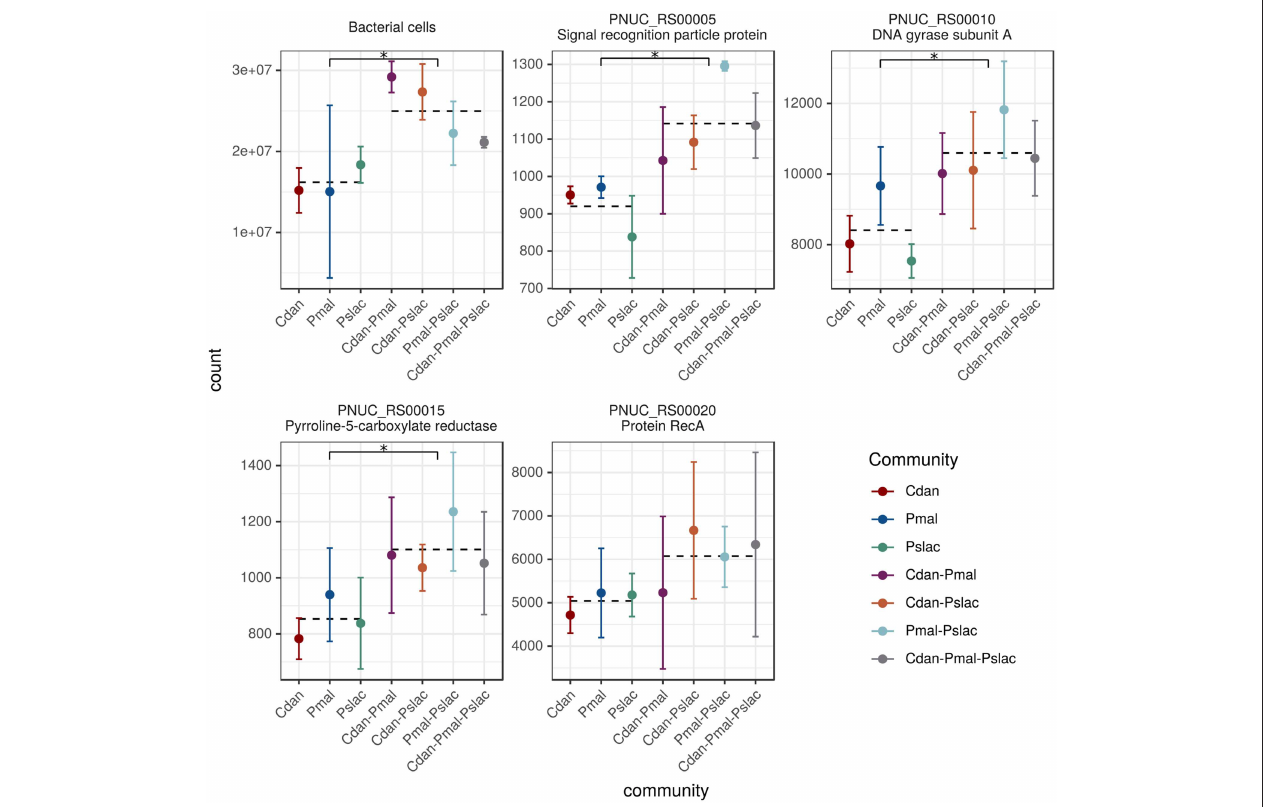
FIGURE 1 | Bacterial cell counts and normalized read counts for housekeeping genes. The five subplots display the bacterial cell counts as well as normalized read counts of four housekeeping genes. The read counts act as further independent estimate of bacterial abundance changes. Since, by definition, the expression of housekeeping genes in a cell is relatively constant, changes in read counts arise from changes in the number of cells/organisms. The following housekeeping genes were considered: recombinase A, signal recognition particle protein genes, pyrroline-5-carboxylate reductase and DNA gyrase. For all counts the mean and the standard deviation over the replicates is shown colored by treatment. The means of the two tested groups (single-species vs. multi-species samples) are highlighted as dotted lines, asterisks mark significant differences in